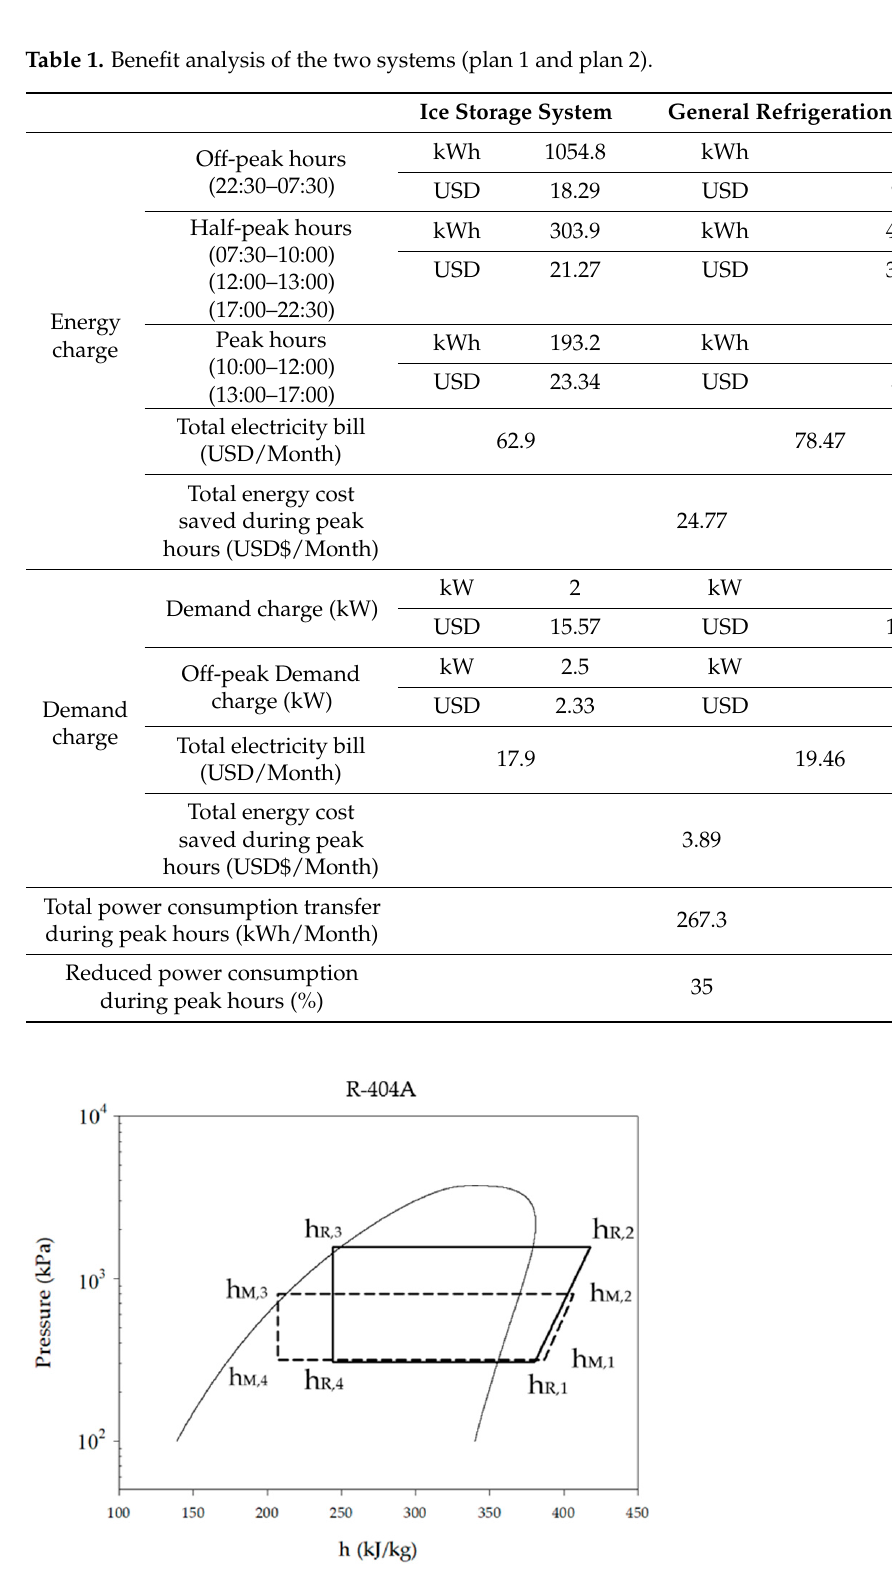
Figure 12. Pressure–enthalpy